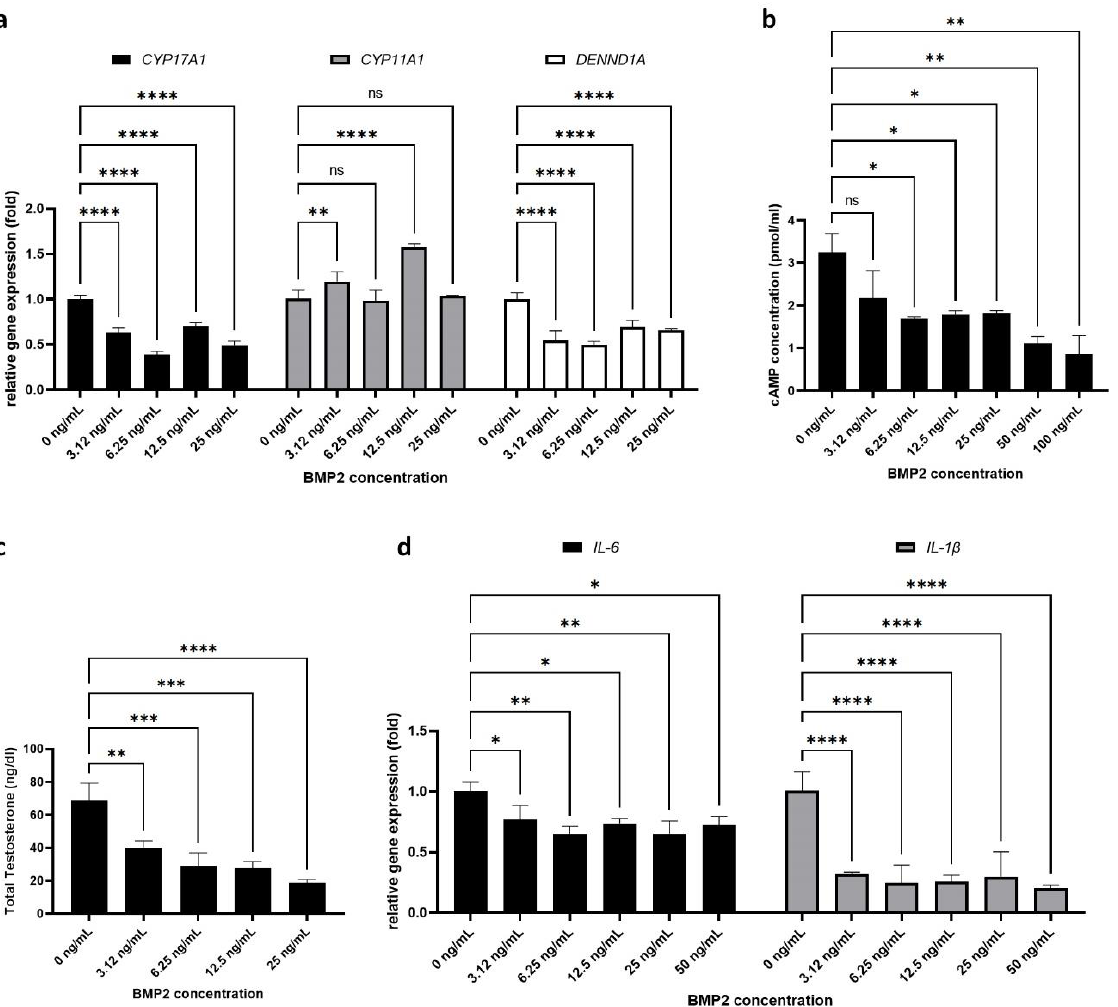
Figure 2. Effect of BMP2 on PCOS-related parameters in H295R cells. ( a ) Relative gene expression of CYP17A1, CYP11A1, and DENND1A in control (0 ng/mL) and BMP2-treated H295R cells (3.125 ng/mL, 6.25 ng/mL, 12.5 ng/mL, 25 ng/mL). ( b ) The cAMP level in H295R cells after treatment with BMP-2 in control (0 ng/mL) and BMP2-treated H295R cells (3.125 ng/mL, 6.25 ng/mL, 12.5 ng/mL, 25 ng/mL, 50 ng/mL, and 100 ng/mL). ( c ) The testosterone level in H295R cells after treatment with BMP-2 in control H295R cells (0 ng/mL) and BMP2-treated H295R cells (3.125 ng/mL, 6.25 ng/mL, 12.5 ng/mL, and 25 ng/mL). ( d ) Relative expression of IL-6 gene expression and IL-1β gene expression in BMP2-treated H295R cells. Data are presented as the mean ± SD. ( n = 3, significance level, * p < 0.05, ** p < 0.005, *** p < 0.0005, **** p < 0.0001; ns: Not significant).